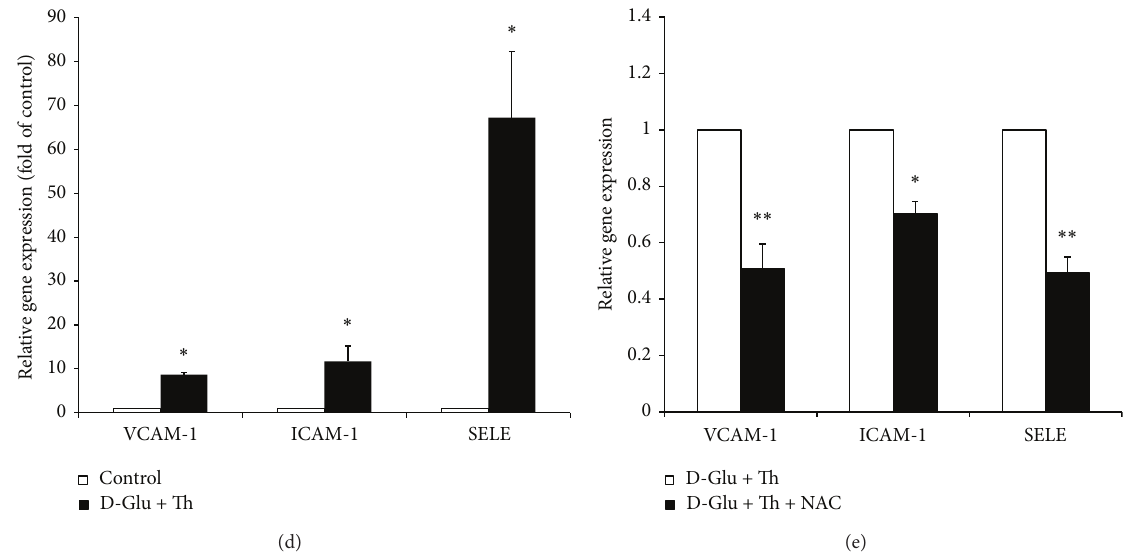
Figure 2: Endothelial inflammation was induced by HG/thrombin through an ROS-dependent pathway. (a) From top to bottom, multiple small dots accumulated into 6 horizontal lines, which represented the expression levels of IL-8, IL-1 𝛽 , IL-6, IL-10, TNF- 𝛼 , and IL-12p70 proteins in conditioned medium. The rightward shift of the dotted lines represents the relative protein expression levels. Analysis using an inflammatory cytokine kit showed that HG/thrombin stimulation increased IL-8 and IL-6 expression in HAECs, while L-1 𝛽 , IL-10, TNF- 𝛼 , and IL-12p70 had no discernible effect on its protein expression levels. The images shown represent the results from 3 independent experiments. (b) Stimulation of HAECs with HG/thrombin for 5 h increased caused 4.06-fold and 5.05-fold increases of IL-6 and IL-8 mRNA gene expression levels, respectively. The bars represent the means ± SEM from 3 experiments. ∗ 𝑃 < 0.05 , as compared with the control. (c) Stimulation of HAECs with HG/thrombin for 5h induced an 11.43-fold synergistic increase of THP-1 adhesiveness to HAECs compared with thecontrol.Thebarsrepresentthemeans ± SEMfrom4experiments. ∗∗ 𝑃 < 0.01 ,ascomparedwiththecontrol.(d)StimulationofHAECswith HG/thrombin for 5h induced significant 8.72-, 11.67-, and 67.21-fold increases of VCAM-1 , ICAM-1 , and SELE gene expression, respectively. The bars represent the means ± SEM from 3 experiments. ∗ 𝑃 < 0.05 , as compared with the control. (e) HAECs were pretreated with 5 mM N- acetylcysteine (NAC) for 1h and then stimulated with HG/thrombin for 5h. Real-time PCR showed that NAC pretreatment caused significant decreases in the gene expression of VCAM-1 , ICAM-1 , and SELE to 51%, 70%, and 49% of that in the HG/thrombin-stimulated HAECs. The bars represent the means ± SEM from 4 experiments. ∗ 𝑃 < 0.05 and ∗∗ 𝑃 < 0.01 , as compared with the